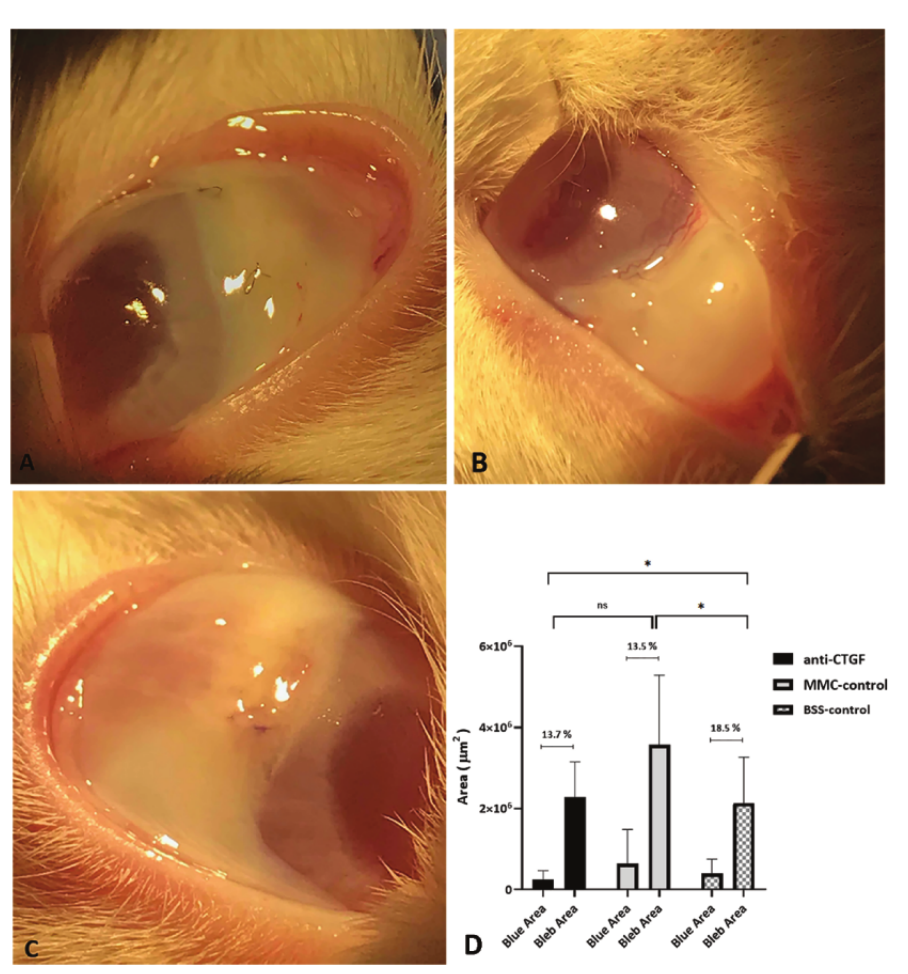
Figure 1. Representative images of trabeculectomy blebs in the study groups. Note the presence of well-formed blebs in the anti-CTGF (A), MMC (B), and control (C) eyes on day 14 postoperatively. (D) Bleb area compared with the blue area in anti-CTGF, MMC, and BSS groups,